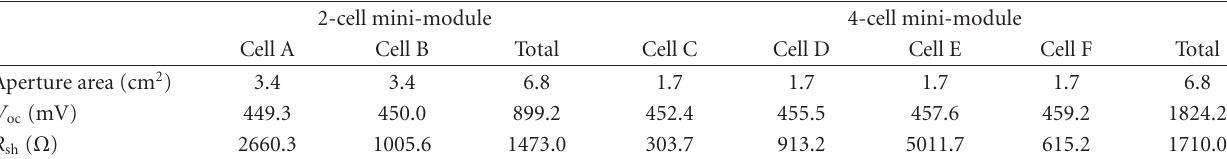
Table 3: Suns- V oc results of the aligned bifacial interconnected metallisation when baked photoresist is used as an insulation layer. 2-cell